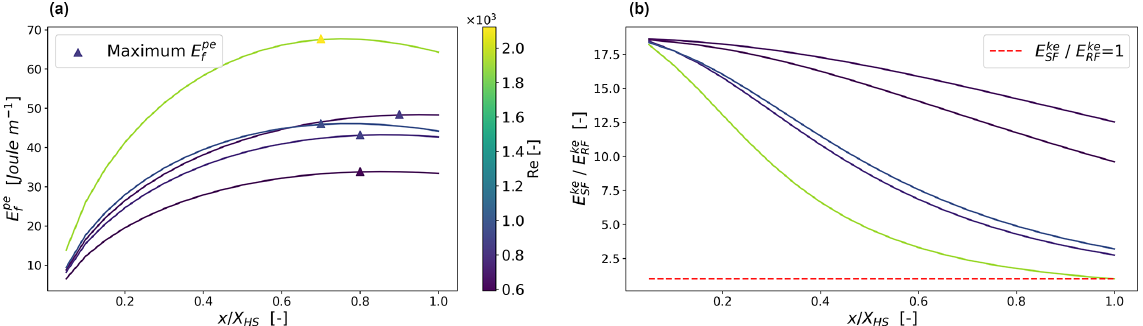
/E ke and (b) E ke for considered experiments in the Weiherbach catchment (compare data in the RF f SF f